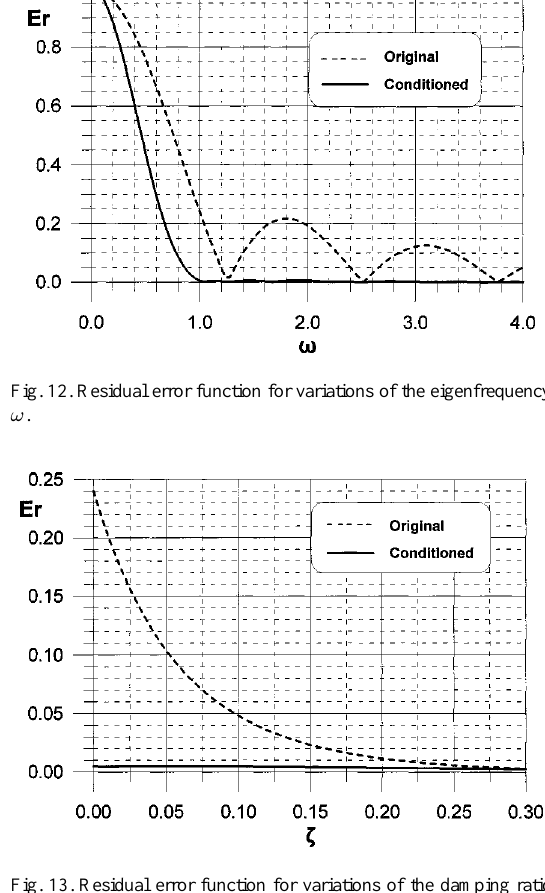
Fig. 11. System response to the unlimited and limited PID control ( ! = 1 rad/s, all other variables set equal to zero). (a) System re- sponse, (b) elastic force on the spring.